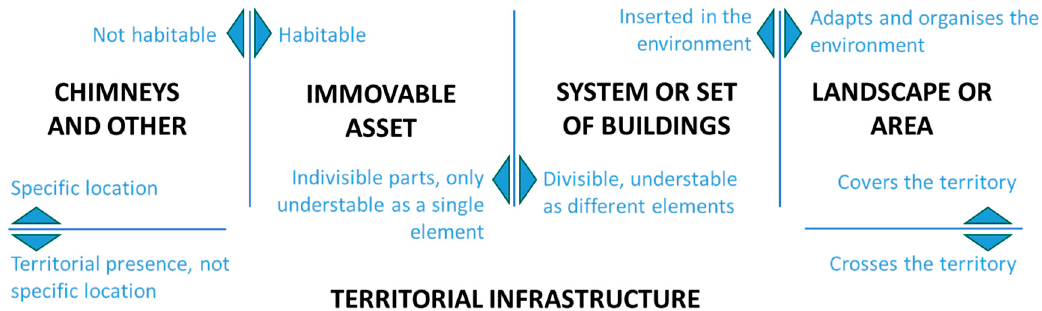
Figure 4. Graphical guidelines for the classification through the scale criterion.